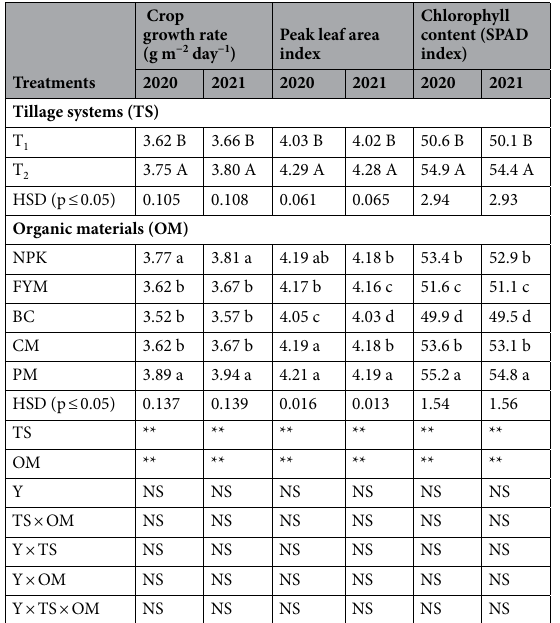
Table 1. Effect of different tillage systems and organic materials on growth attributes, and chlorophyll content of cotton crop. Values sharing the same alphabet letters did not differ markedly at p ≤ 0.05 for a particular